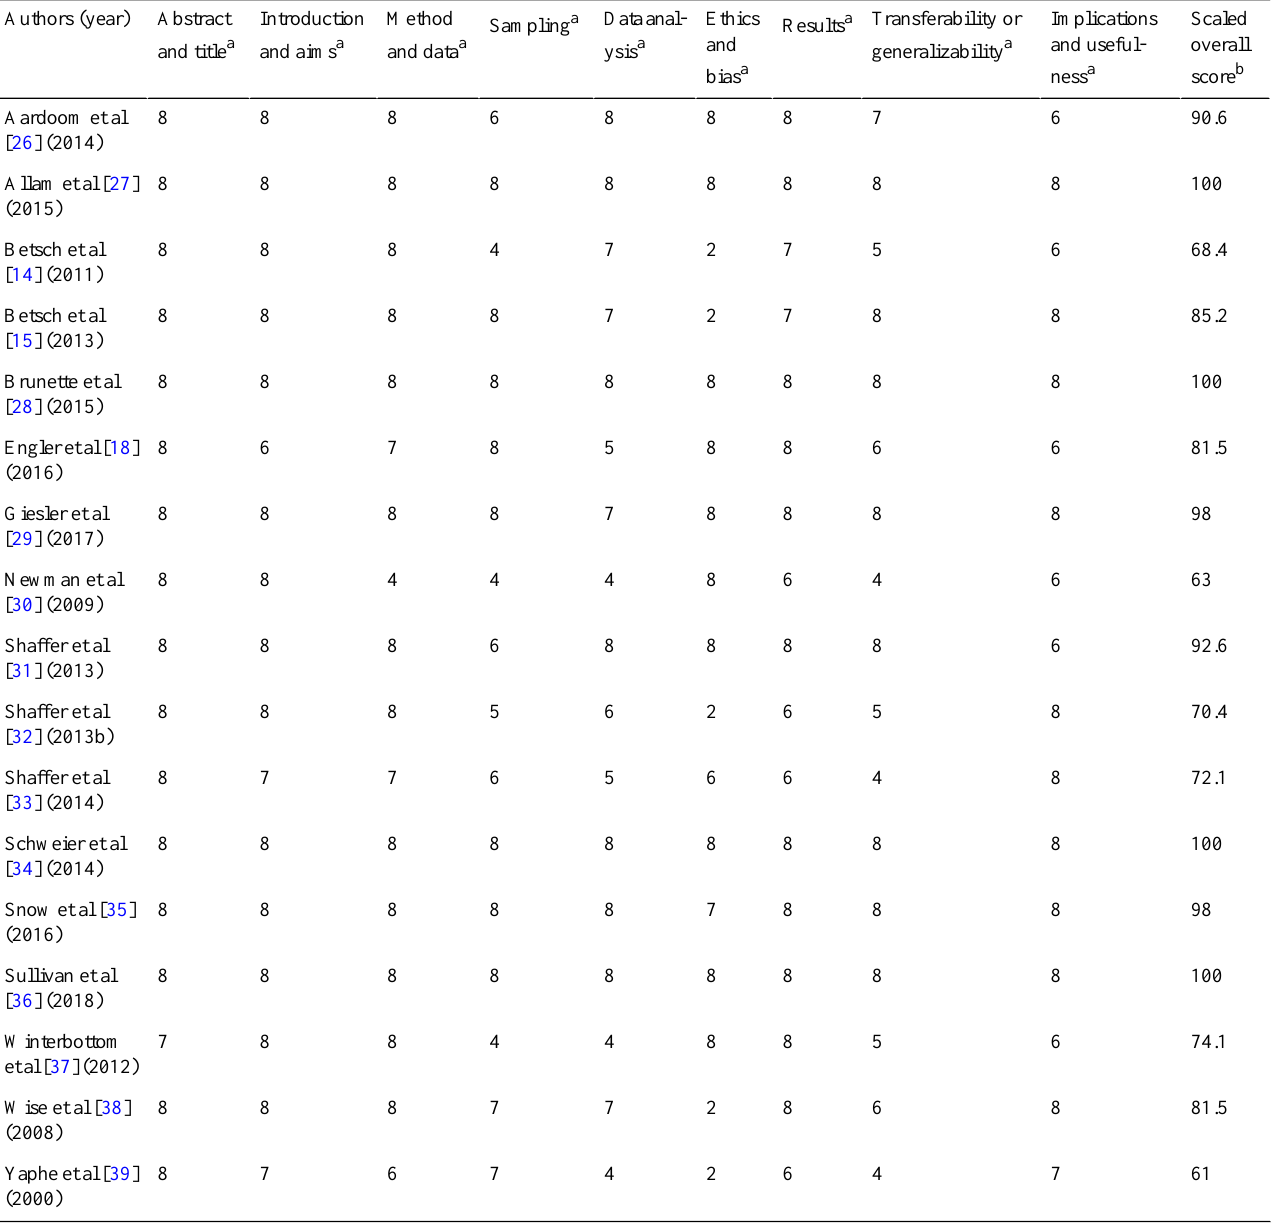
Table 3. Quality assessment of included